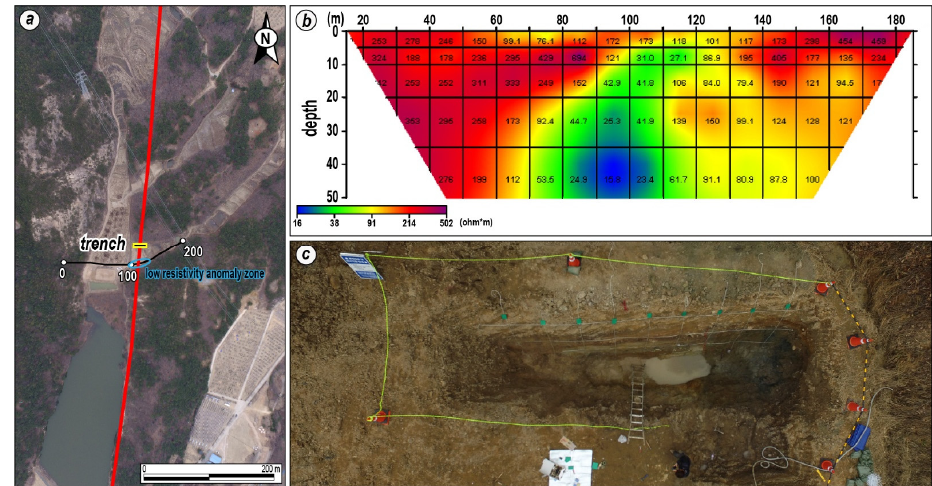
Figure 8. ( a ) Location of the electrical resistivity survey line (black line) and trench site (square). The red line and blue circle indicate the main lineament and a low resistivity anomaly zone, respectively. ( b ) Electrical resistivity tomography (ERT) result. The blue zone, between 105–120 m, was selected as the trench site because of its low resistivity extending to the surface. ( c ) Trench site plan view. Remote Sens. 2022 , 14 , x FOR PEER REVIEW